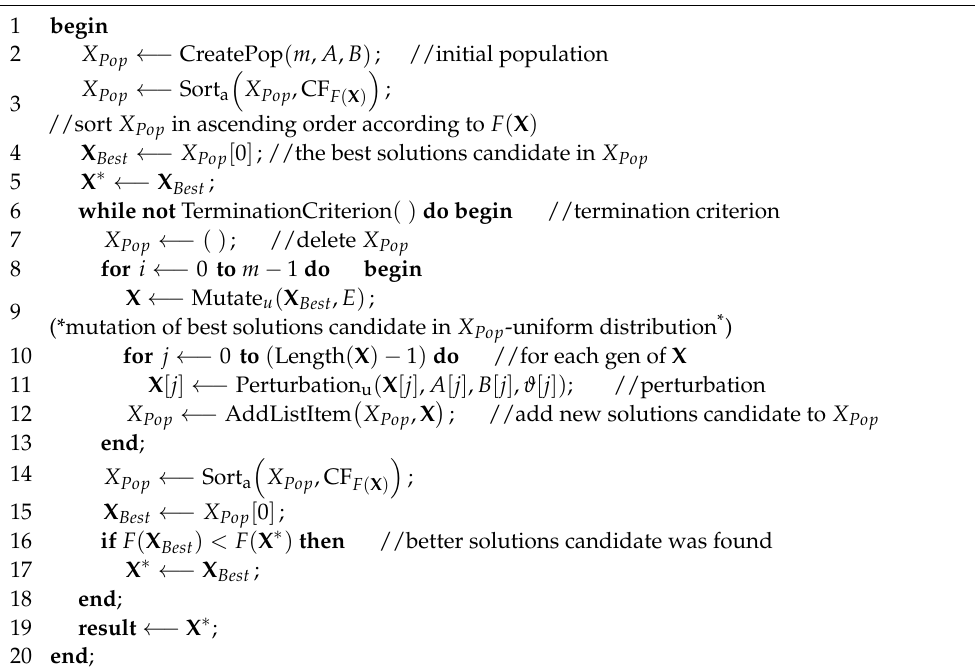
Algorithm 1: Stochastic Hill-Climbing Algorithm Pseudocode